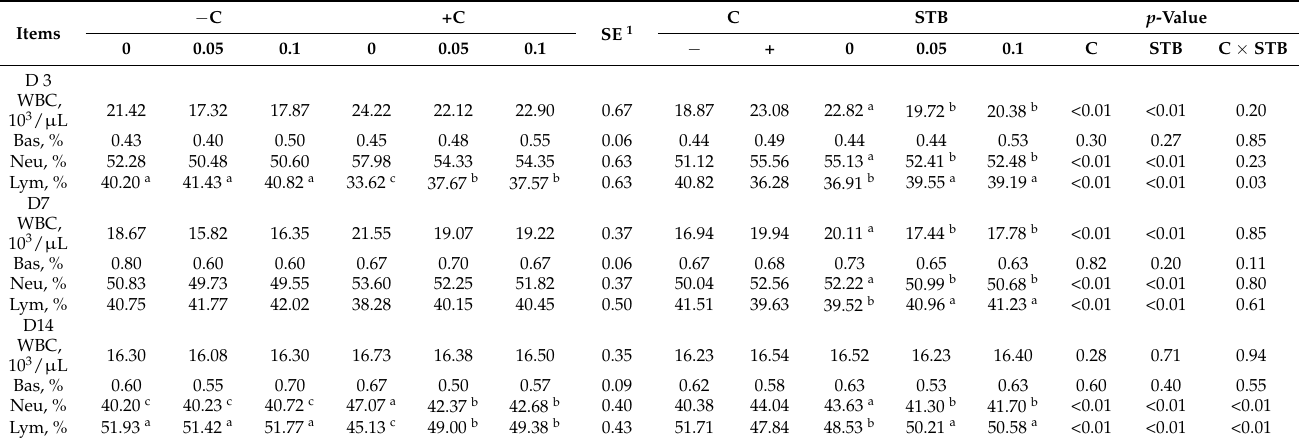
Table 5. Effects of stimbiotic supplementation on the blood profile of pigs challenged with STEC.